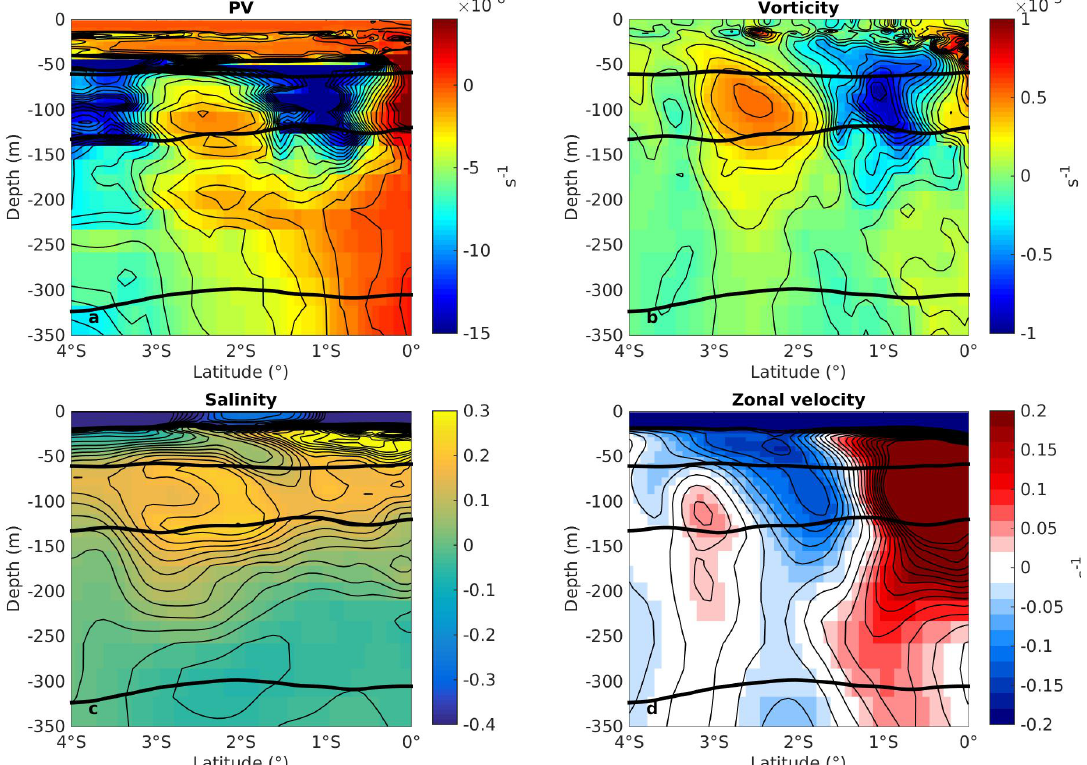
Figure 10. Meridional sections of PV ( a ), vorticity ( b ), salinity anomaly (with respect to the annual mean, ( c ) and zonal velocity U ( d ) along 1.1 ◦ E, on 10 May. The section passes across the eddy described in Figure 9. Thick black lines represents the isopycnic levels defining layers 1 and 2. Thin lines represents isovalues (Steps: 10 − 6 s − 1 for PV and vorticity, 0.025 for salinity and 2.5 cm/s for